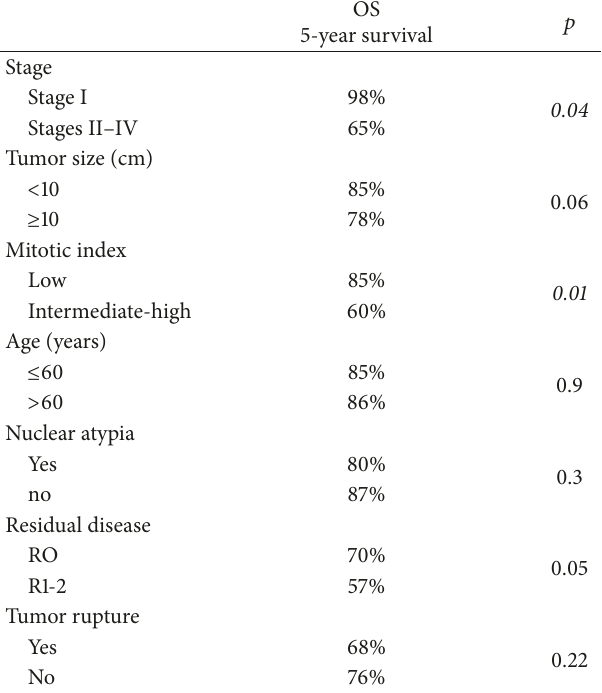
Table 2: Univariate analysis of overall